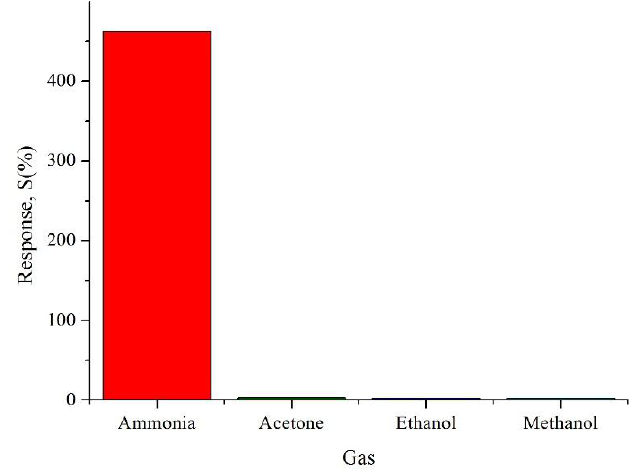
Figure 11. Sensor response of 0.02 M CSA-doped PA6/PANI composite nanofibers to 250 ppm different